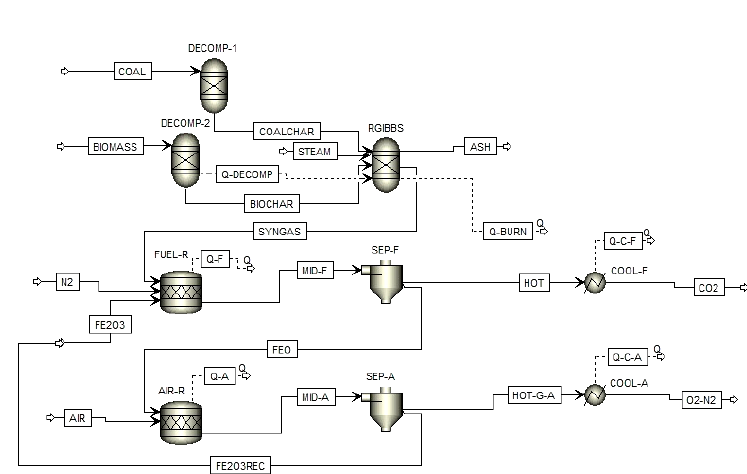
Figure 2 depicts the CLC process simulation that used two interconnected fluidized bed reactors developed in Aspen Plus. In the current simulation study, bituminous coal and sawdust were considered as the two solid fuels for combustion in the presence of Fe 2 O 3 . Figure 2 presents the arrangement of various Aspen Plus library models to signify the system level processes. RYIELD reactors represent the pyrolysis of the coal and bio- mass fuel separately [13]. The RGIBBS reactor collected the outcomes of both RYIELD re- actors and also performed char gasification in the presence of steam. The combustion of the generated flue gases performed in RSTOIC (fuel reactor) in the presence of an oxygen carrier (Fe 2 O 3 ) to produce CO 2 , H 2 O and Fe 3 O 4 in the fuel reactor can be presented as shown in Figure 2.